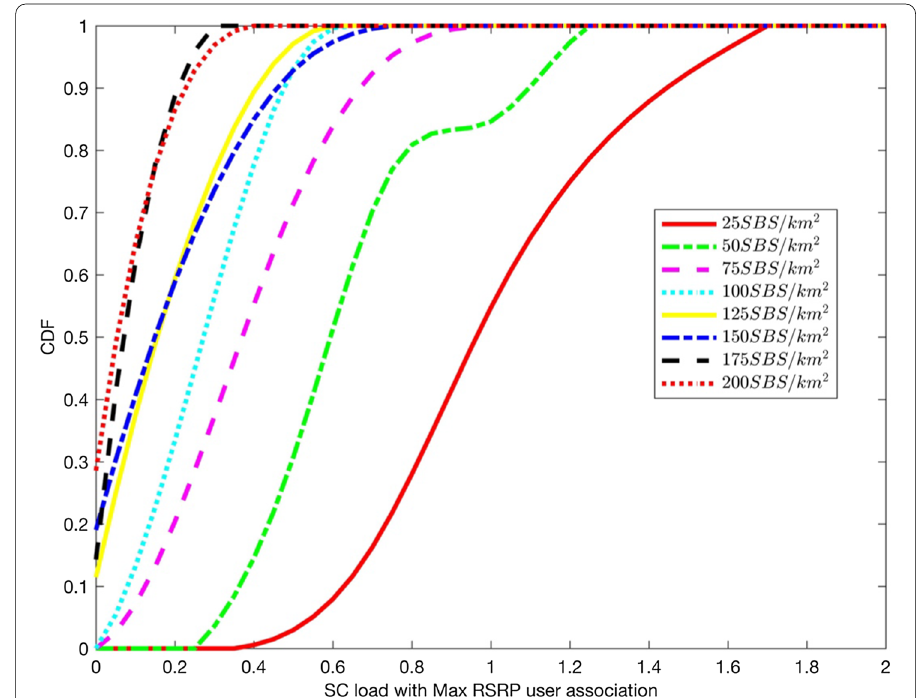
Fig. 6 SC load of Max RSRP user association versus the different density of SBSs